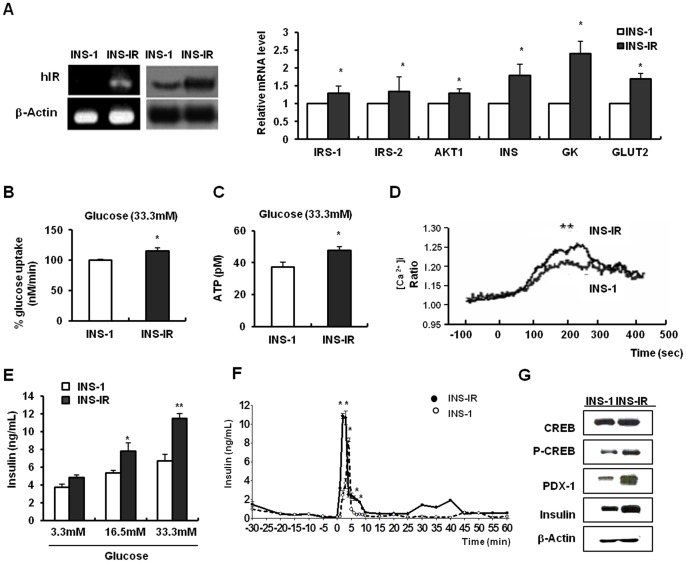
IR overexpression improves β-cell functions.The plasmid pCMV6 containing the human IR cDNA was stably transfected into INS-1 NS-IR cells). A, Left panel: Comparison of hIR band by using RT-PCR and the western blot method. Right cells (I panel: Relative mRNA levels of β-cell markers and insulin signaling intermediators using real time PCR. B, Radio-labeled glucose incorporation into INS-1 and INS-IR cells in response to 33.3 mM glucose stimulus. C, Intracellular ATP concentration using a luciferin/LUC method. D, Fura-2 AM staining Ca2+ influx into cells using a microfluorometric system. E, Insulin concentration in media in response to glucose stimulus. F, First-phase and second-phase insulin release pattern. Insulin secretion was tested by perfusion with KRBB containing 33.3 mM glucose. G, Protein levels of CREB/PDX-1/insulin using the western blot method. Values are mean ± SE of three independent experiments, each performed in triplicate. *P<0.05, **P<0.001 INS-1 vs. INS-IR cells (Student t-test).